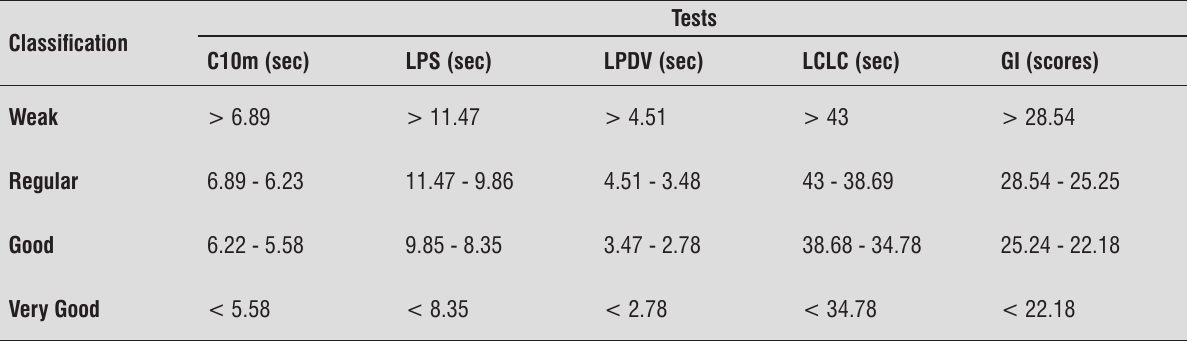
Table 2 - Classification of functional autonomy by GDLAM